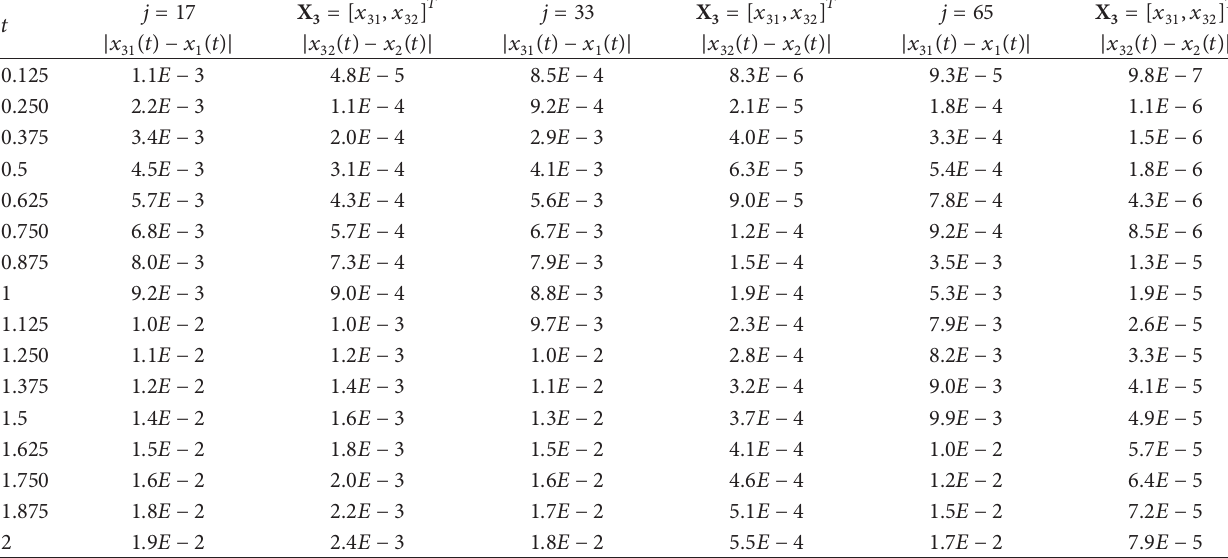
Table 6: Absolute errors for Example